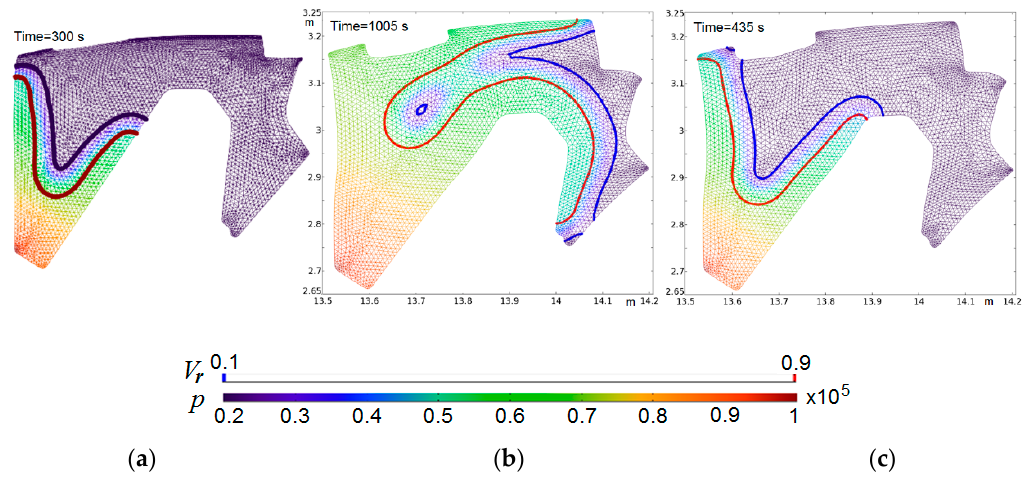
Figure 19. Three snapshots corresponding the time instants when no dry spot formation ( a ), dry spot formations by the inner ( b ) and by the outer ( c ) resin flow front.